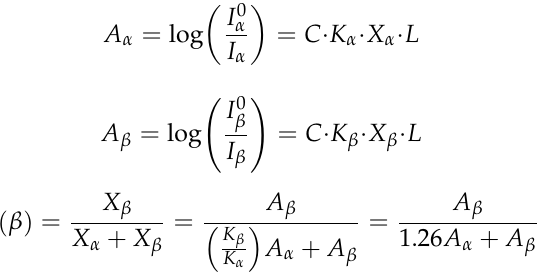
Figure 7. FT-IR spectra of the PVDF/PAR composites drawn at different temperatures.